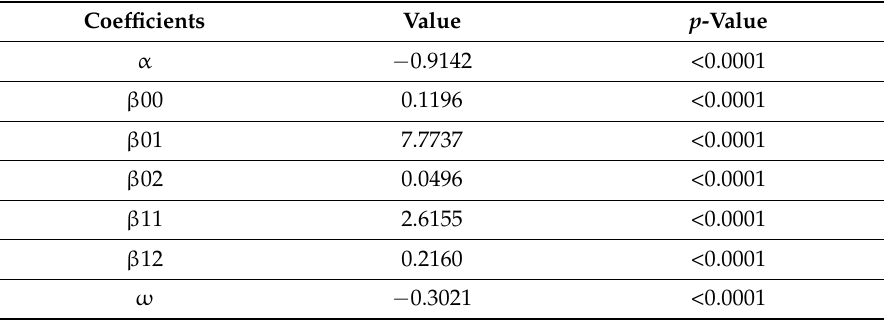
Table 5. Fixed coefficients of height adjustment model for CHM (Equations (3)–(5)).